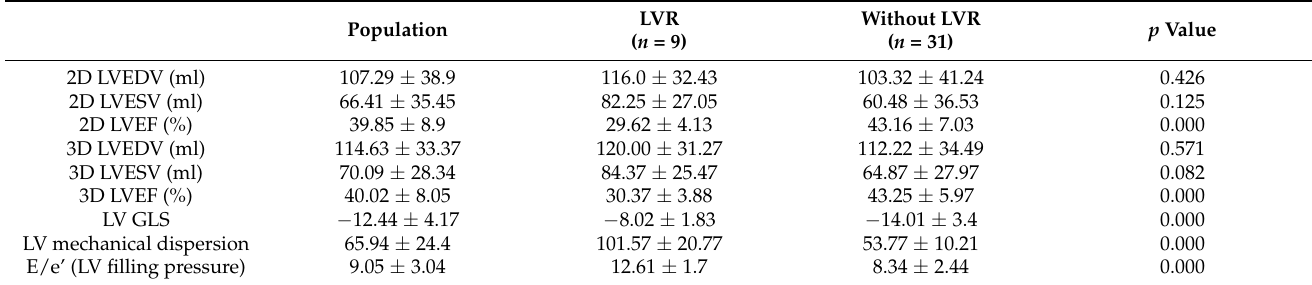
Table 2. Echocardiographic parameters at baseline for the entire study population and divided into subgroups according to the occurrence of LVR at follow up.